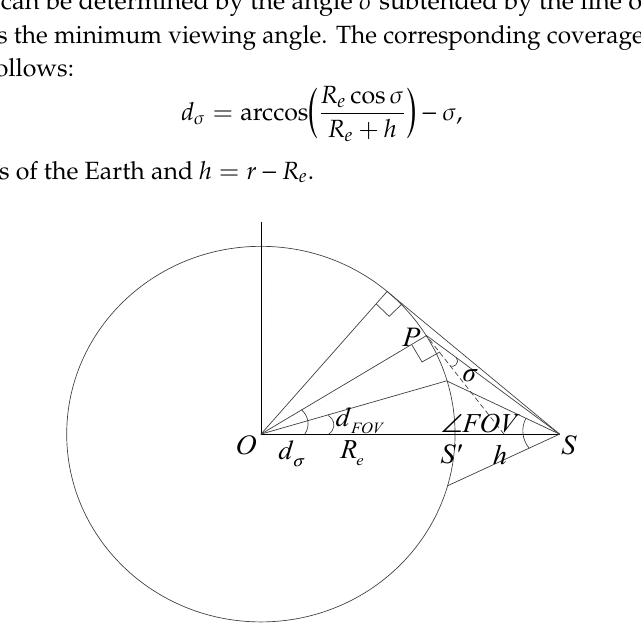
Figure 4. Satellite ground coverage. h is the instantaneous height of the satellite S at time t, S’ is the sub-point of the satellite on the Earth’s surface, σ is the minimum viewing angle, and d σ is the corresponding coverage angle.